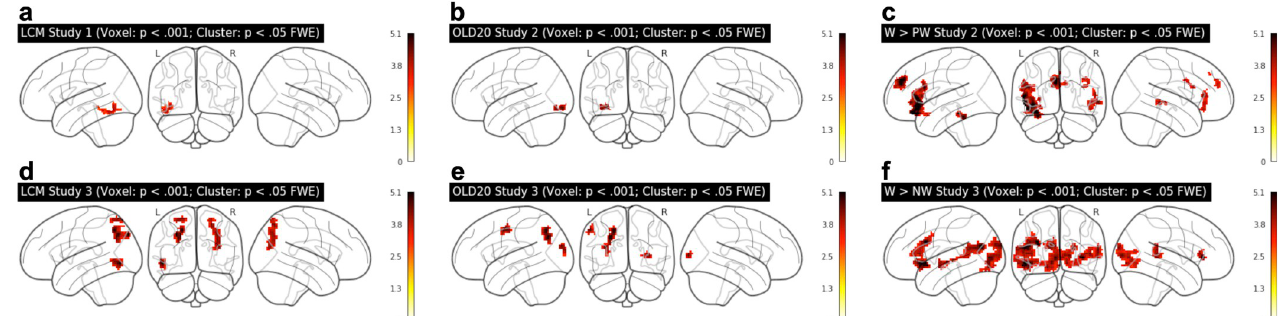
Fig 3. fMRI-based Evaluation of the LCM model: fMRI whole brain analyses. (a, b, d, e) Significant correlation results between BOLD signals and LCM simulations modeled as a single, continuous predictor in Study 1 (a) and Study 3 (d), and between BOLD activation and word-likeness represented by the OLD20 as a single, continuous predictor in Study 2 (b) and Study 3 (e). (c, f) Significantly increased BOLD signals for words as compared to non-words in Study 2 (c) and Study 3 (f). For OLD20 results and word > non-word contrasts of Study 1, see S2 Fig). Thresholds for all whole brain analyses: voxel level: p < .001 uncorrected (cluster-forming); cluster level: p < .05 family-wise error corrected. No other regions than those displayed were significant.